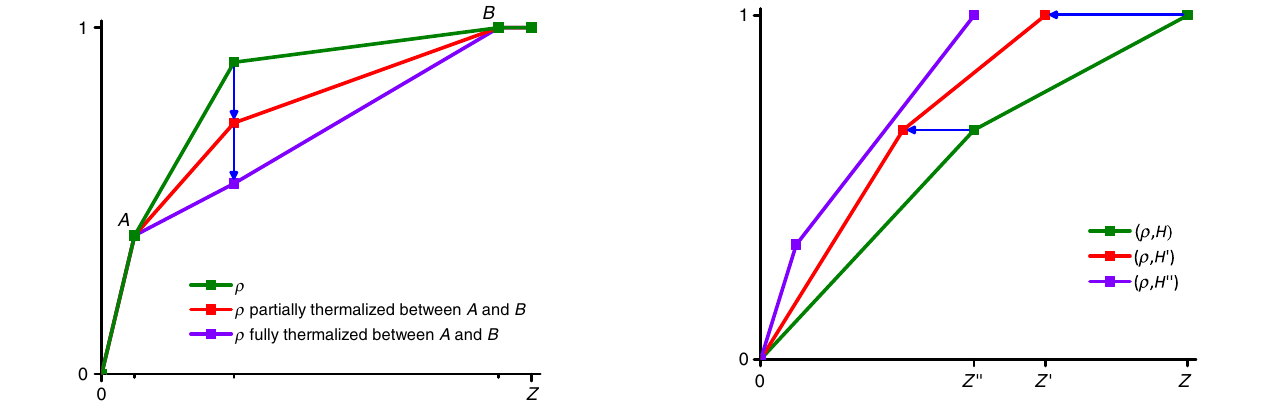
FIG. 4. Action of level transformations. Here we illustrate the FIG. 3. Action of partial level thermalization. Here we illustrate action of LTs applied to a system with a thermodynamical the action of PLTs applied to a state four-level system with configuration ð ρ ; H Þ . Note that LTs leave the occupation prob- P ¼ f 0 ; 1 g . We take ρ to be block diagonal in the energy abilities of ρ unchanged but may alter the β ordering as discussed eigenbasis with occupation probabilities p ¼ ð 0 . 1 ; 0 . 5 ; 0 . 4 ; 0 Þ in Supplemental Material and H S and β to be such that e − β E 1 ¼ 0 . 4 , e − β E 2 ¼ 0 . 15 , and e − β E 3 ¼ e − β E 4 ¼ 0 . 05 . For these choices, the affected portion of the thermomajorization curve lies between the points A and B and we show the impact of PLT ð λ ¼ 0 . 5 Þ (partial thermalization) f 1 ; 2 g and PLT ð λ ¼ 1 Þ (full thermalization) on ρ . f 1 ; 2 g